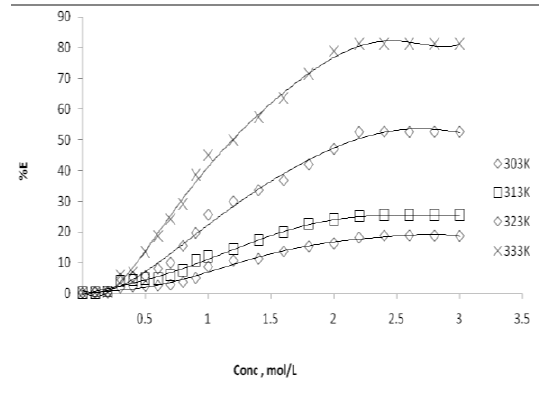
Figure 3. Effect of sodium pseudocumene sulfonate concentration ( C ) on percentage extraction( %E) of m-aminoacetophenone.